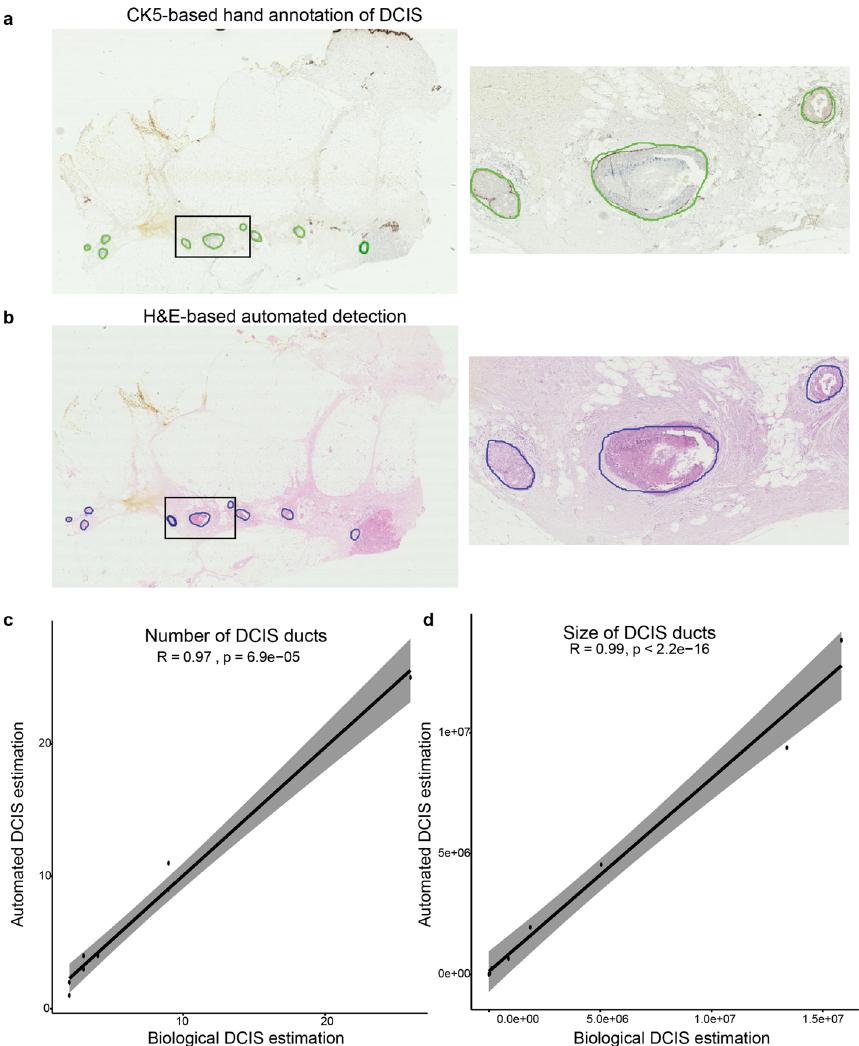
Fig. 4 Biological validation of automated DCIS detection using CK5 immunohistochemistry. a An example showing CK5 IHC image where DCIS regions were annotated by hand following the CK5 expression pattern, indicated by green contour. b Segmented H&E image with DCIS regions marked in blue contour by IM-Net for the same sample. c Quantitative assessment of the IHC-H&E correlation between H&E-based automated DCIS detection result and hand annotations on IHC using an estimated number of DCIS. d Quantitative assessment of the IHC-H&E correlation between H&E-based automated DCIS detection result and hand annotations on IHC using an estimated area of